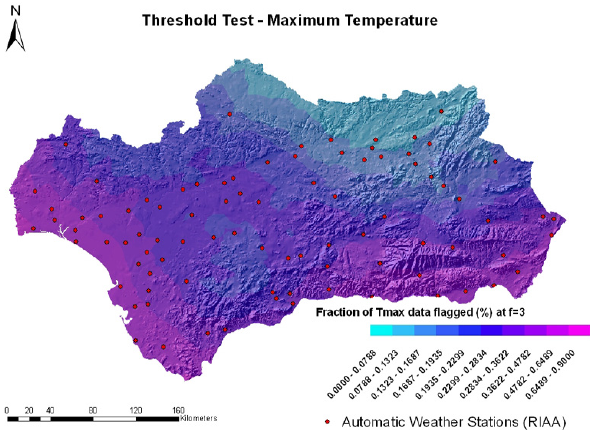
Figure 5. Fraction of maximum temperature data flagged at f = 3 for threshold